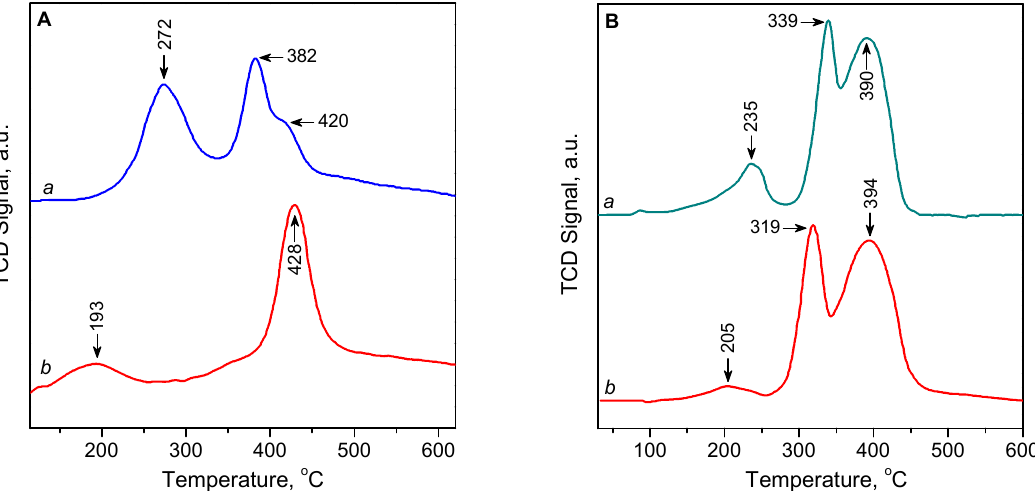
Figure 7. ( A ) H 2 -TPR profiles of 3.1CuZ23(AE): pre-treated in He/O 2 at 500 ◦ C (a) and reduced with He/CO at 300 ◦ C (b). ( B ) H 2 -TPR profiles of 9.7CuZ23(SE): pre-treated in He at 500 ◦ C (a) and reduced with He/CO at 300 ◦ C (b).